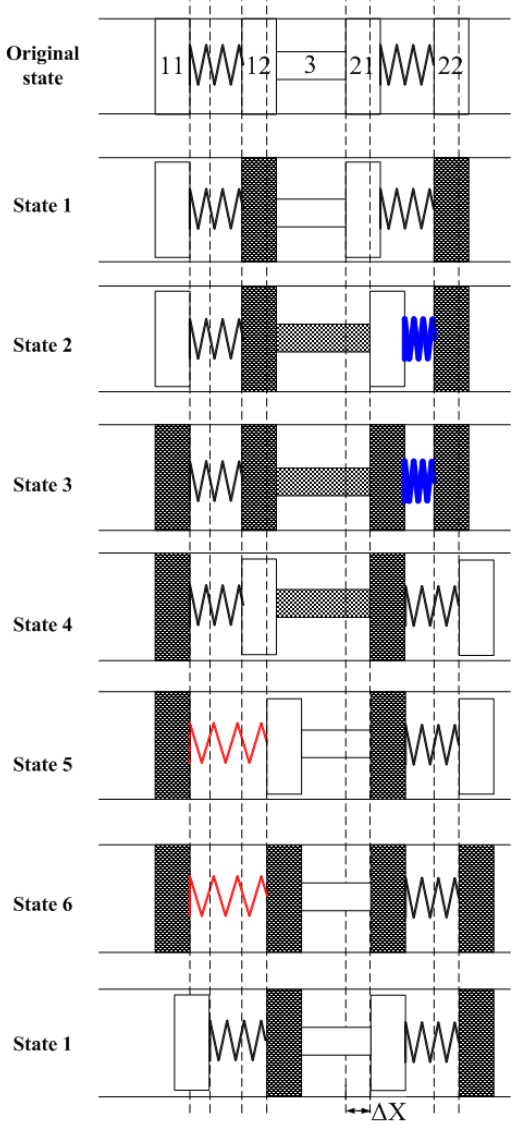
Figure 5. States of the actuator during one operation period.